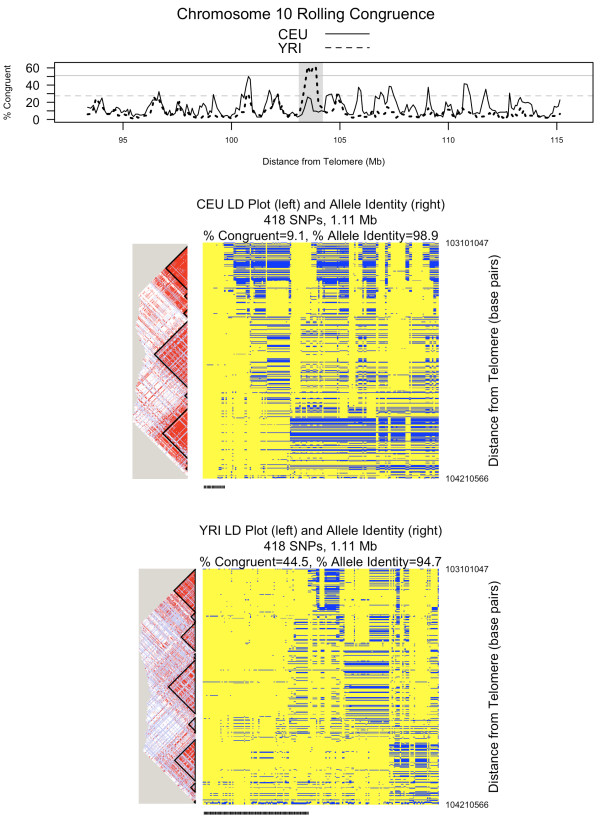
Comparing unrelated HapMap populations: chromosome 10. This figure shows rolling congruence over a section of chromosome 10. Detailed linkage disequilibrium (LD) plots with haplotype blocks and allele identity plots correspond to the shaded peak. The two horizontal reference lines on the rolling congruence plot correspond to the 99th percentile of congruence observations across the genome. That value is 51.1% for CEU (solid line) and 27.5% for YRI (dotted line). On the LD plots, shades of red indicate increasing D'. For the allele identity plots, each column is one chromosome (as represented by 418 SNPs and 1.11 Mb) and each row is a SNP. Yellow represents alleles that match the consensus sequence whereas blue represents alleles that do not match the consensus. Congruent chromosomes are indicated by the tick mark at the bottom of the allele identity plot. This peak on chromosome 10 (near 103 Mb) demonstrates high YRI congruence but lower CEU congruence